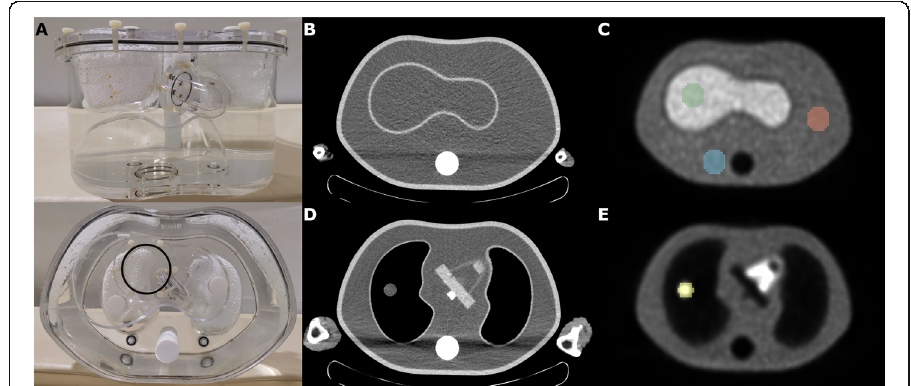
Fig. 1 The DataSpectrum anthropomorphic phantom (lamb shanks not shown and the lung “ tumour ” is obscured by the polystyrene in the lung cavities) ( a ). Axial CT slices of the DataSpectrum anthropomorphic phantom, with adjacent lamb shanks and custom lung “ tumour ” insert ( b , d ) and corresponding axial slices of the reconstructed PET ( c , e ) with ROIs for the liver (green), soft tissue (orange), soft tissue in an area of CT beam hardening (blue) and the lung “ tumour ” (yellow). ROIs were copied to ensure consistent placement and no overlap into adjoining